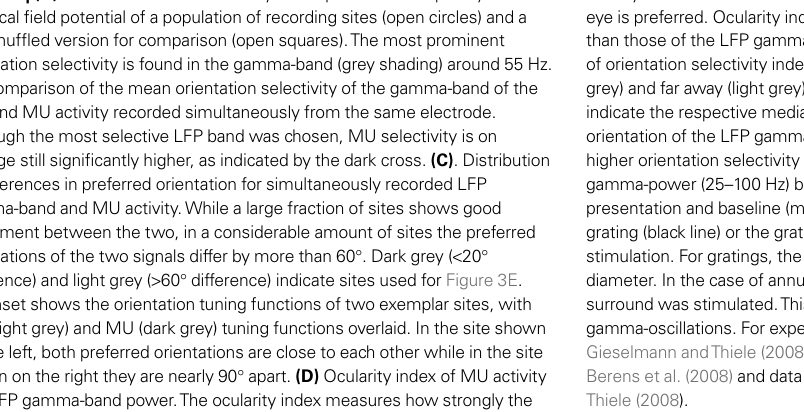
Figure 3 | (A) Mean orientation selectivity of the power in a frequency band of the local fi eld potential of a population of recording sites (open circles) and a trial shuffl ed version for comparison (open squares). The most prominent orientation selectivity is found in the gamma-band (grey shading) around 55 Hz. (B) Comparison of the mean orientation selectivity of the gamma-band of the LFP and MU activity recorded simultaneously from the same electrode. Although the most selective LFP band was chosen, MU selectivity is on average still signifi cantly higher, as indicated by the dark cross. (C) . Distribution of differences in preferred orientation for simultaneously recorded LFP gamma-band and MU activity. While a large fraction of sites shows good agreement between the two, in a considerable amount of sites the preferred orientations of the two signals differ by more than 60 ° . Dark grey ( < 20 ° difference) and light grey ( > 60 ° difference) indicate sites used for Figure 3E. The inset shows the orientation tuning functions of two exemplar sites, with LFP (light grey) and MU (dark grey) tuning functions overlaid. In the site shown on the left, both preferred orientations are close to each other while in the site shown on the right they are nearly 90 ° apart. (D) Ocularity index of MU activity and LFP gamma-band power. The ocularity index measures how strongly the